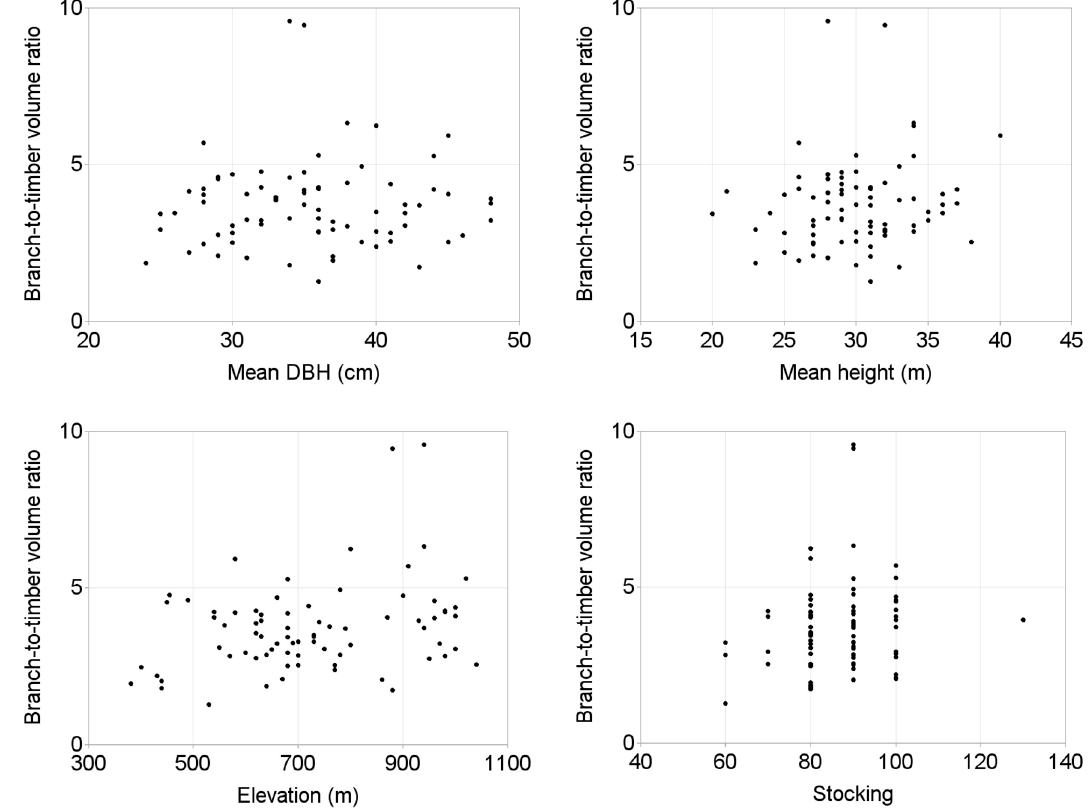
Figure 4. Scattered plots of branch-to-timber volume ratio versus other variables.